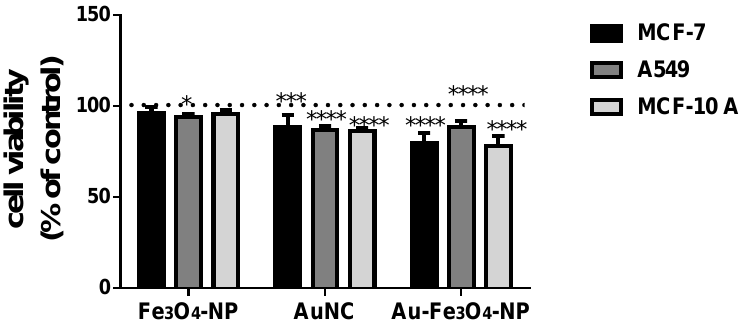
Figure 8. Cell viability of MCF-7, A549 and MCF-10A cells loaded with Fe 3 O 4 NPs, AuNC or Fe 3 O 4 @Au pNPs, AuNC ( n = 6, * p < 0.05, *** p < 0.001, **** p < 0.0001). The respective cell viability data in Figure 8 were obtained by conducting the neutral red assay. The dashed line at 100% represents the viability of the respective control cells. Fe 3 O 4 @Au